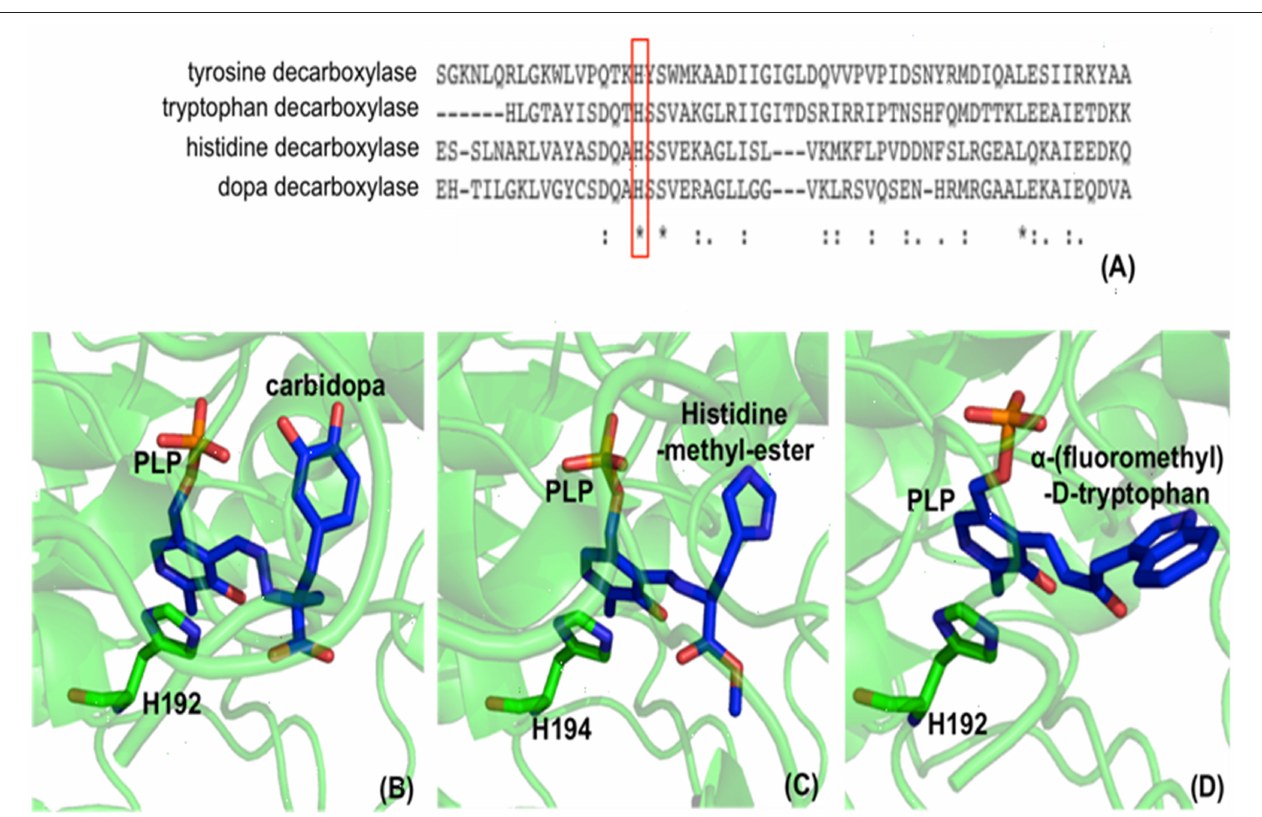
FIGURE 4 | Partial protein sequence alignment of aromatic amino acid decarboxylases, and the positions of the conserved His residue in aromatic amino acid decarboxylases. The conservation of His192 residue (residue number is from Drosophila melanogaster dopa decarboxylase) in Lactobacillus brevis tyrosine decarboxylase (PDB: 5HSJ, chain A) ( Zhu et al., 2016), Ruminococcus Gnavus tryptophan decarboxylase (PDB: 4OBU, chain E) (Williams et al., 2014), Homo sapiens histidine decarboxylase (4E1O_A) (Komori et al., 2012), and Drosophila melanogaster dopa decarboxylase (Accession: NP_724164.1) is shown and is highlighted in red box (A) . The dopa decarboxylase complexed with PLP and substrate-like inhibitor carbidopa [PDB: 1JS3 (Burkhard et al., 2001)] (B) , the histidine decarboxylase complexed with PLP and substrate analog histidine-methyl-ester [PDB: 4E1O (Komori et al., 2012)] (C) , and tryptophan decarboxylase complexed with PLP